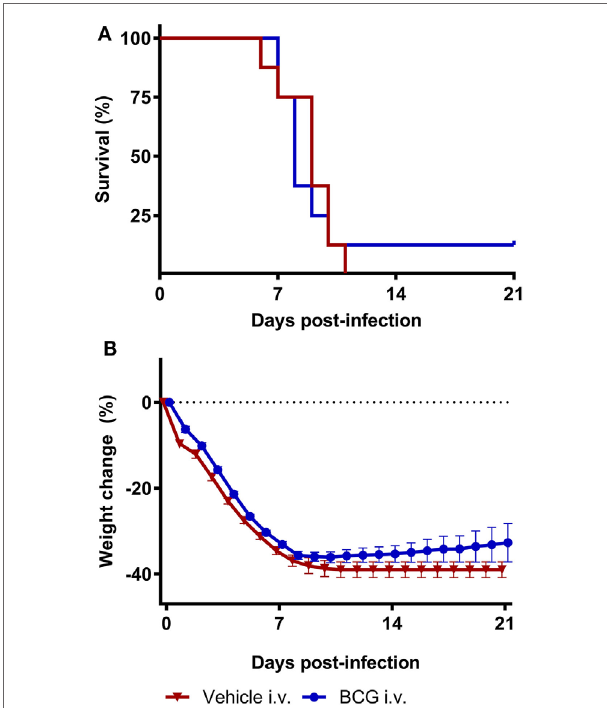
FigUre 4 | Bacillus Calmette–Guérin (BCG) vaccination does not protect mice during H7N9 influenza infection. Female BALB/c mice were challenged with a dose of 4MLD 50 influenza A/Anhui/1/2013 (H7N9) on day 0. Mice received 750 µg BCG or the vehicle control (phosphate buffered saline) i.v. on day − 7. Kaplan–Meyer survival curve (a) and mean body weight change (B) are depicted. Survival proportion in the BCG treated group was statistically analyzed using a Fisher’s exact two-sided test. Survival time was statistically analyzed using a Mantel and Cox log-rank test. The effect of BCG treatment on body weight was analyzed by comparing the area under curve of treatment groups with vehicle and was statistically analyzed using a two-way ANOVA with Bonferroni correction. Data are shown as mean ± SEM, n = 8 per